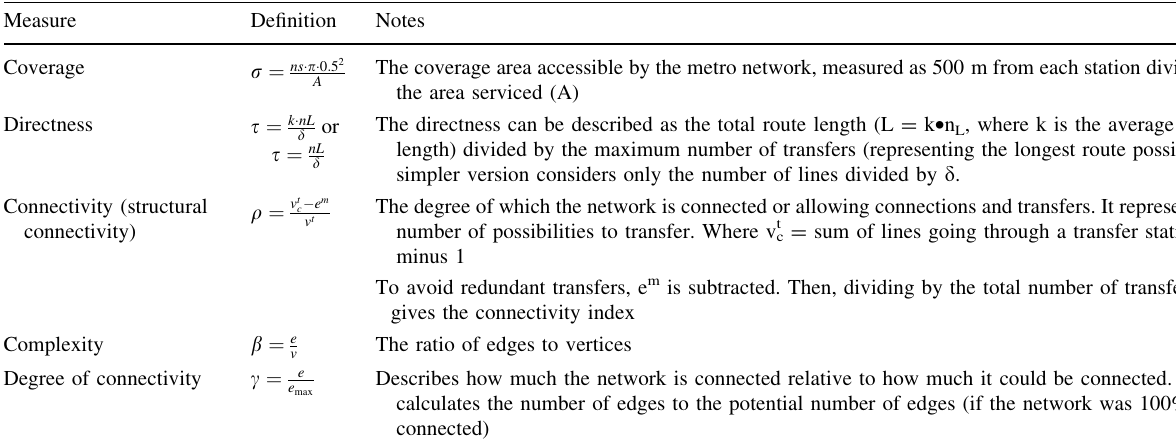
Table 1 Network measures in Derrible and Kennedy